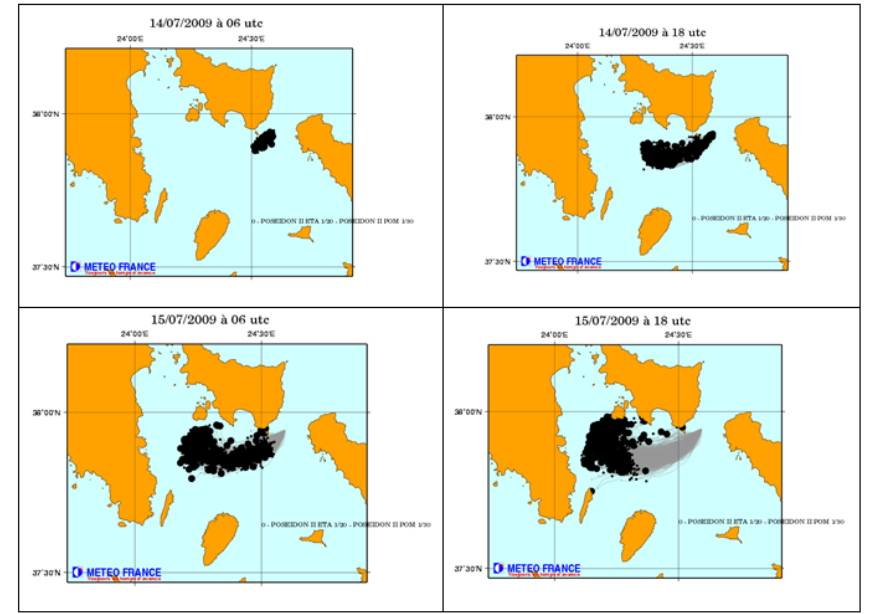
Figure 8: Simulation of oil spill evolution of a hypothetical accident as computed by Aegean DeSS (event : 14/07/2009 02h10 UTC, 37°N57’ ‐ 24°E36’ ; forcing data provide by POSEIDON models (atmospheric resolution 1/20 o , oceanographic and waves 1/30°). Graphics produced by Meteo France, through the use of the common output file provided by HCMR.